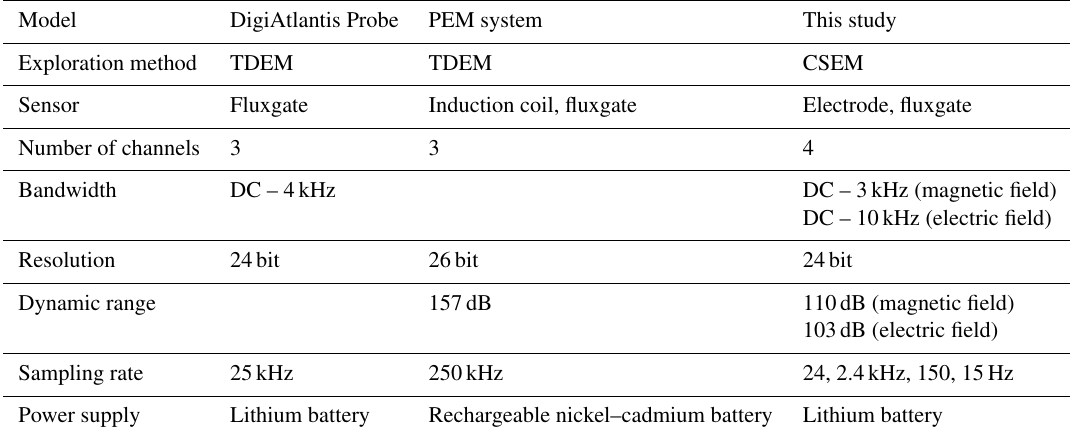
Table 1. Comparison of the performance indicators of available borehole electromagnetic observation equipment. TDEM denotes time domain electromagnetic